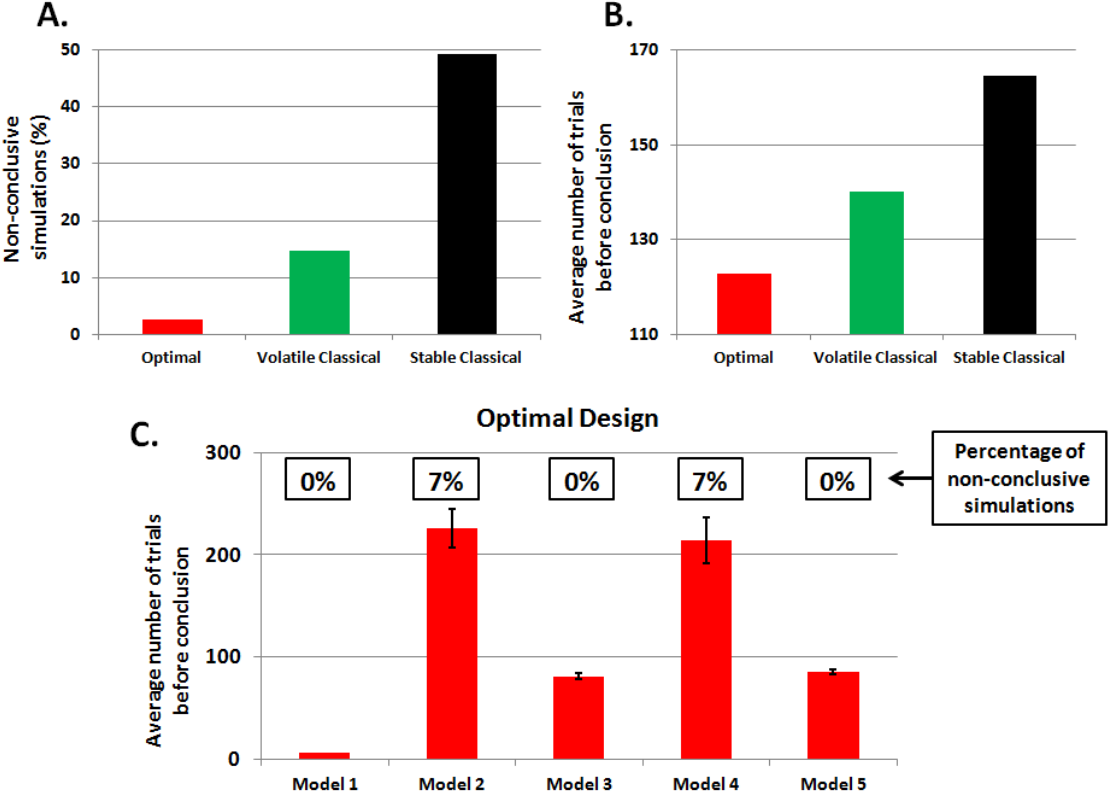
Figure 7. Adaptive design optimization (ADO) with learning models: simulation results. Note that a simulated experiment is deemed “conclusive” whenever the true model posterior probability is equal to or greater than 95%. ( A ) The number of non-conclusive experiments for each design; ( B ) the average number of trials needed to reach the 95% threshold in conclusive simulations; ( C ) the average number of trials before the conclusion and the percentage of non-conclusive simulations (note that in our case, 7% means one non-conclusive experiment over